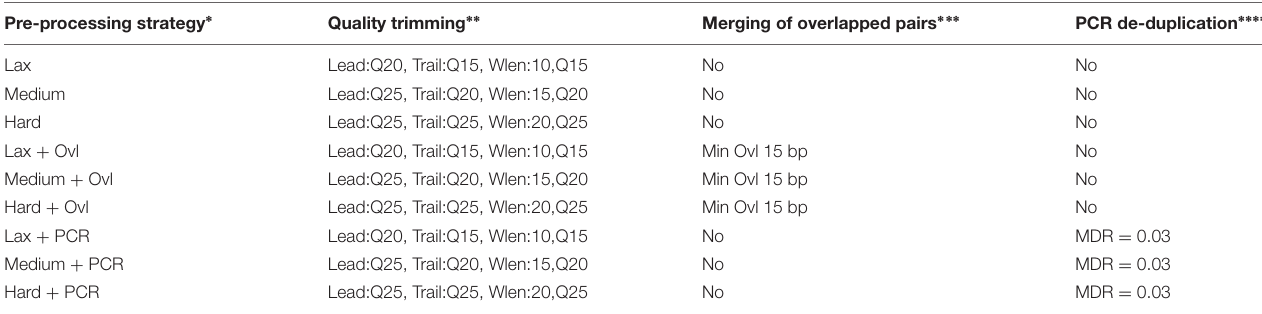
TABLE 1 | Read pre-processing strategies used in this